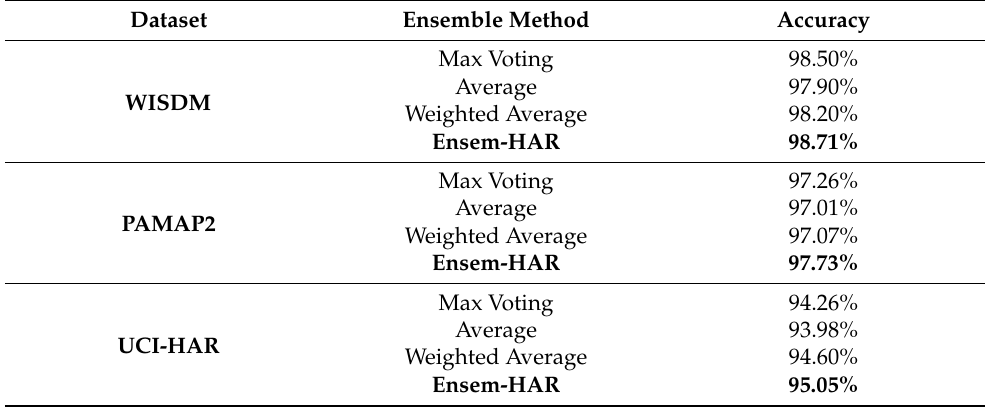
Table 7. Performance comparison (measured in terms of accuracy) of our proposed Ensem-HAR model with three state-of-the-art ensemble techniques for three HAR